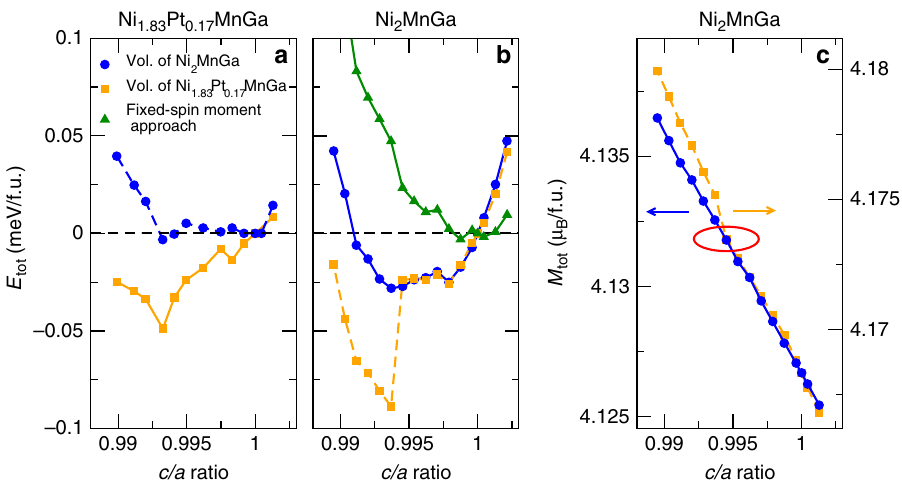
Fig. 8 Calculations for energy vs c/a variation. Variation of the total energy at T = 0 K with c/a ratio for the 3M premartensite phase of a Ni 1.83 Pt 0.17 MnGa and b Ni 2 MnGa. Square symbols correspond to calculations performed at the equilibrium volume of Ni 1.83 Pt 0.17 MnGa, while circles denote calculations performed at the equilibrium volume of Ni 2 MnGa. The energy computed with fi xed-spin moment approach for Ni 2 MnGa at the equilibrium volume of Ni 1.83 Pt 0.17 MnGa is shown by triangles. c The variation of magnetic moment with c/a ratio for Ni 2 MnGa at its optimum volume (circles) and at the optimum volume of Ni 1.83 Pt 0.17 MnGa (squares). The red ellipse marks a discontinuous jump of the magnetization (yellow